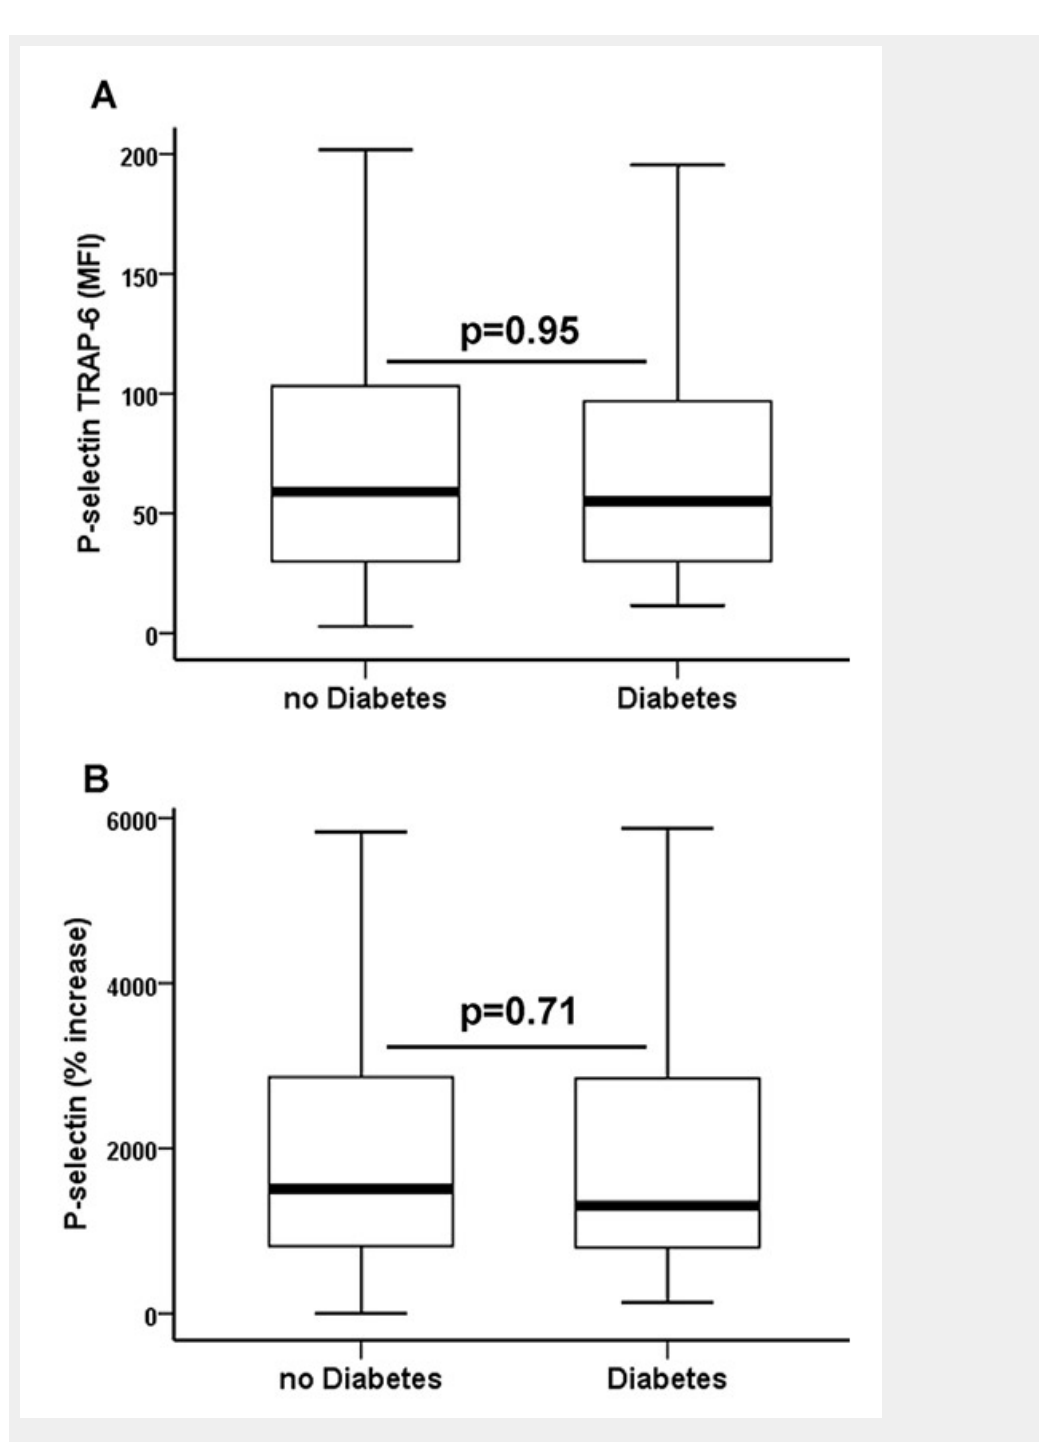
Figure 1 (A) Thrombin receptor activating peptide-6 (TRAP-6) inducible P-selectin (P-selectin TRAP-6) and (B) relative increase of platelet P-selectin (% increase) after activation with TRAP-6 in patients with peripheral artery or cerebrovascular disease without and with type 2 diabetes. The boundaries of the box show the lower and upper quartiles of data, the line inside the box represents the median. Whiskers are drawn from the edge of the box to the highest and lowest values that are outside the box but within 1.5 times the box length. MFI = mean fluorescence